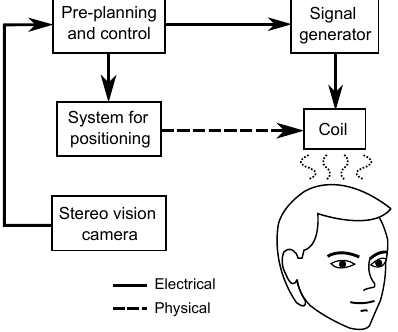
Figure 1. Block diagram of main components of TMS